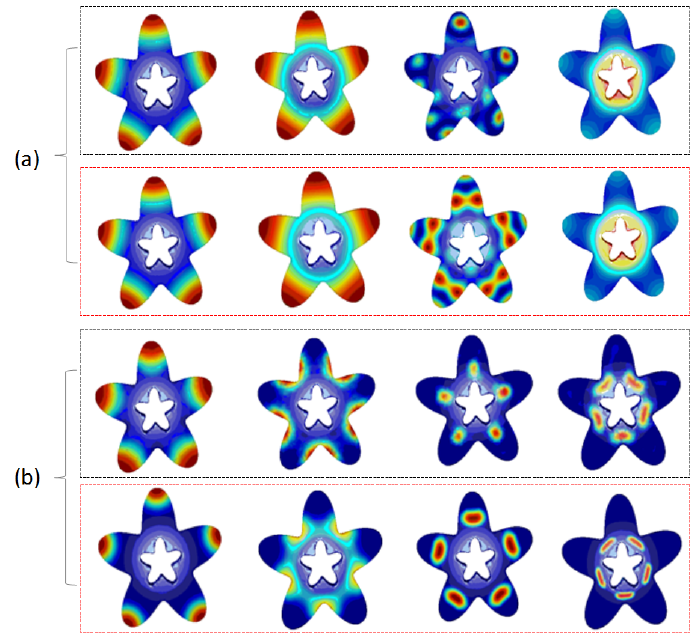
Figure 12. Comparisons on the robustness of bases to the low-quality models, with ( a , b ) showing the bases achieved by GISIFs and our method, dark and red rectangles highlighting the low and high quality models,